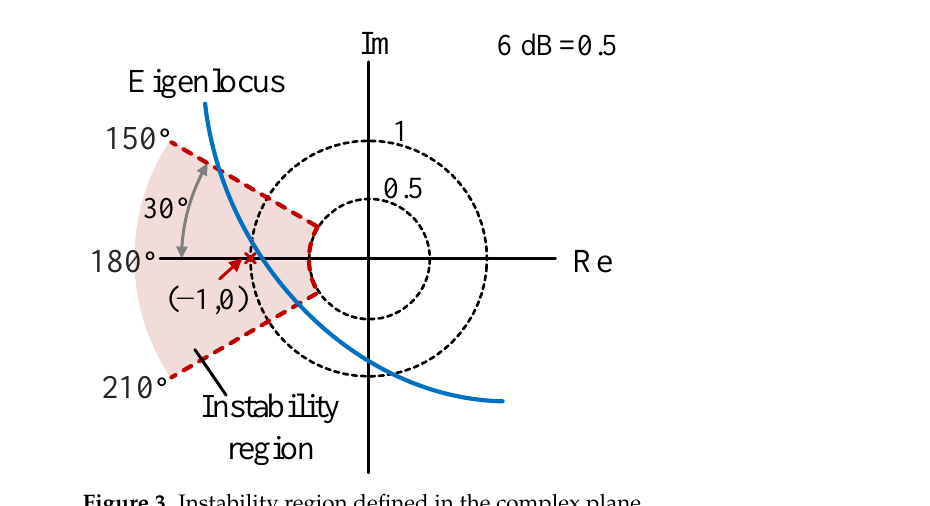
Figure 3. Instability region defined in the complex